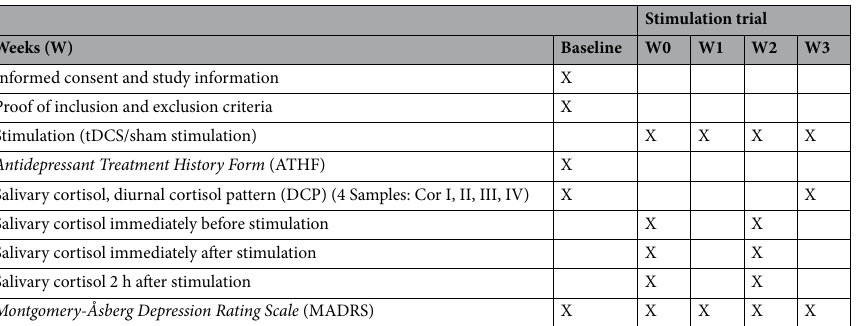
Table 1. Trial schedule and measurements (trial period = 3 weeks = 21 days). tDCS, transcranial direct current stimulation; W0, first stimulation; W1, one week after first stimulation; W2, two weeks after first stimulation; W3, three weeks after first stimulation; Cor I, salivary cortisol measured between 7:30 and 8:00 AM; Cor II, salivary cortisol measured between 8:00 and 8:30 AM; Cor III, salivary cortisol measured between 3:30 and 4:00 PM; Cor IV, salivary cortisol measured between 9:30 and 10:00